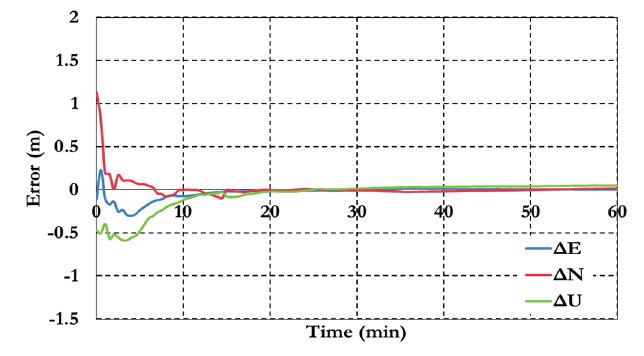
Figure 9. Positioning results of the GPS decoupled clock model.